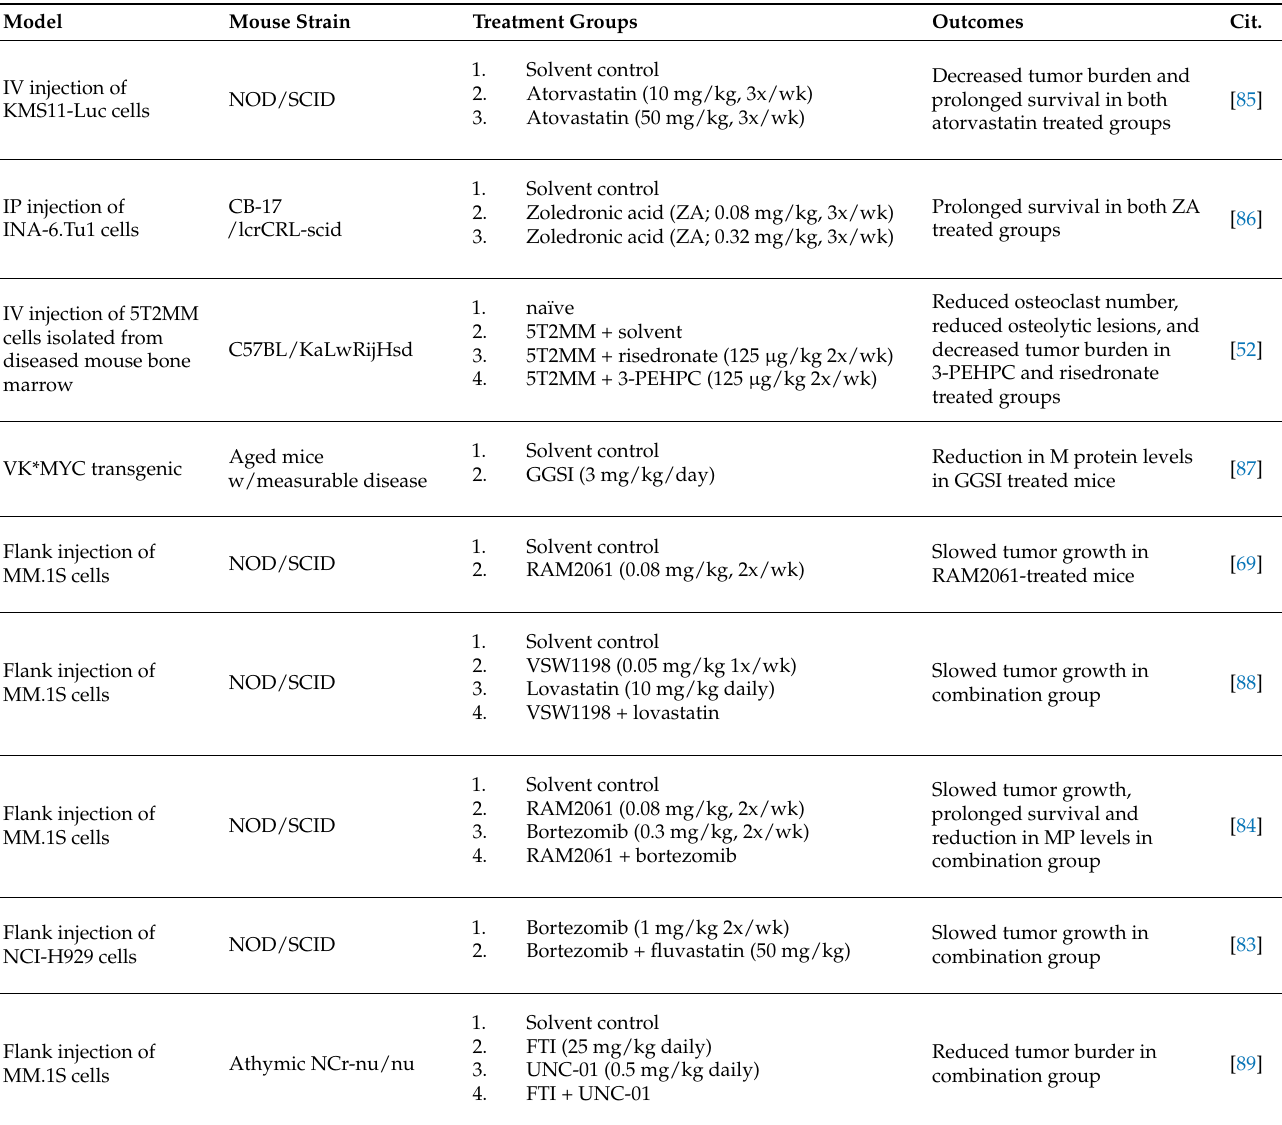
Table 1. Summary of in vivo studies utilizing IBP